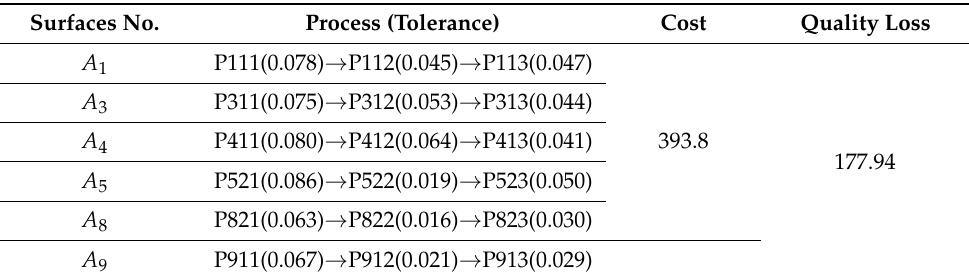
Table 8. Optimal IDP-T scheme of a used gearbox by BAS.